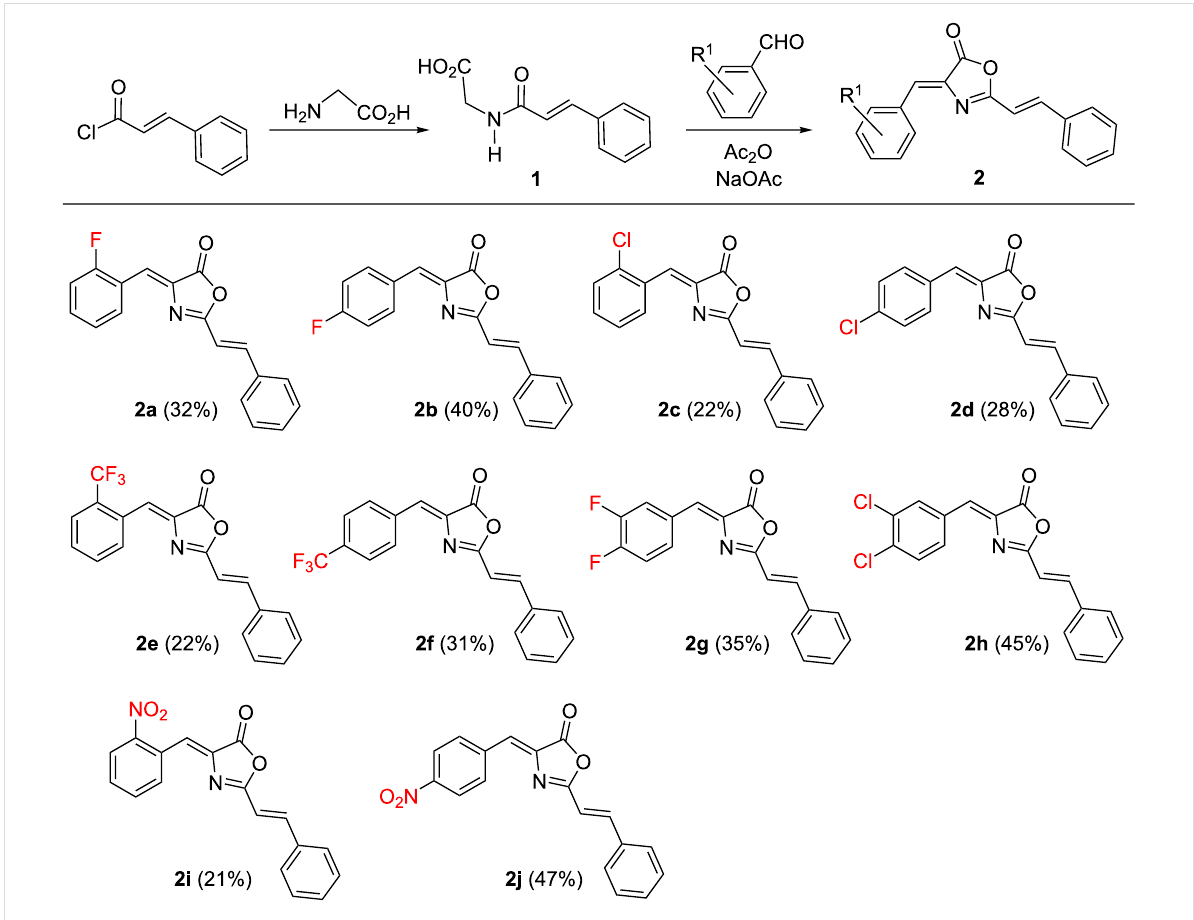
Figure 3: ( Z )-4-Arylidene-2(( E )-styryl)-5(4 H )-oxazolones 2a – j used in this work and overall reaction